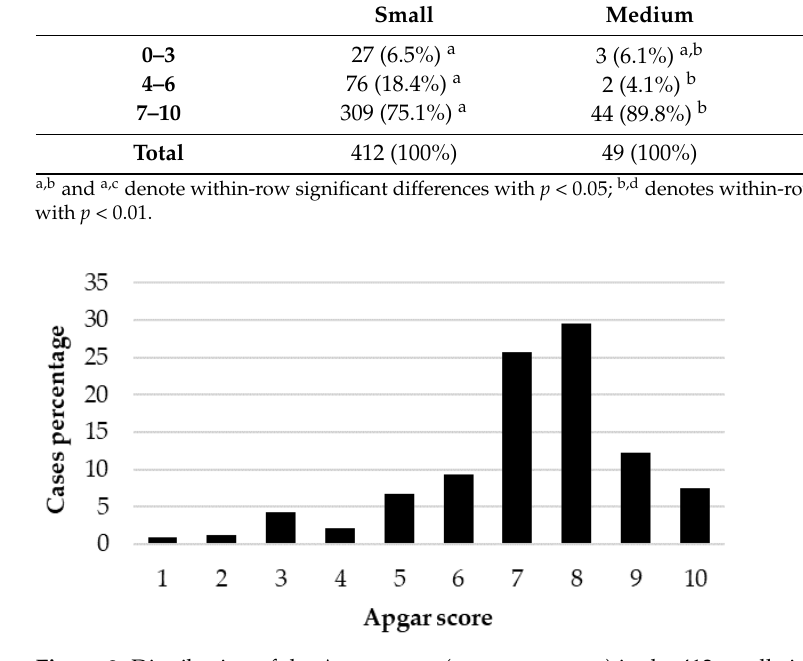
age) is reported in Table 5. Table 5. Distribution (expressed as number and %) of the 1039 live-born puppies in the viability classes.